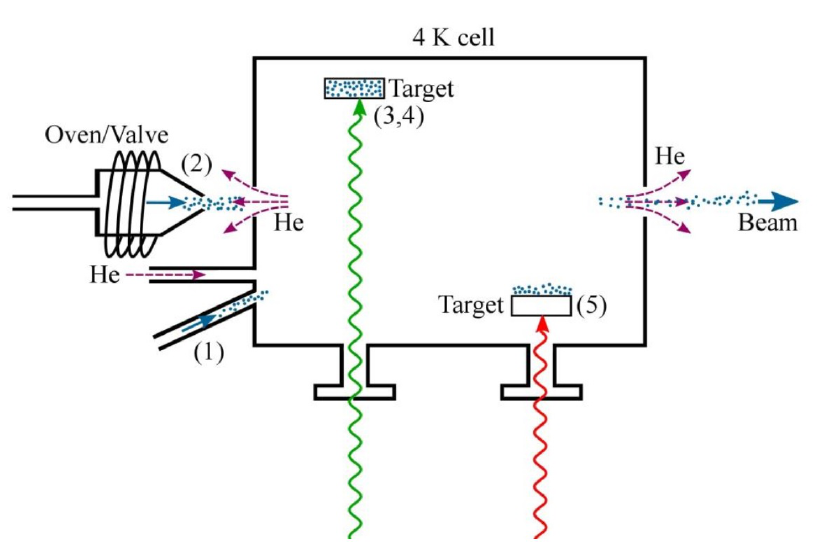
Figure 3. Different molecule-loading mechanisms into a buffer gas cell: (1) Capillary filling, (2) load- ing from a valve or oven, (3) direct laser ablation of the target, (4) matrix-assisted desorption, (5) laser-induced acoustic desorption of a solid target containing the molecules of interest [105]. Repro- duced with permission from